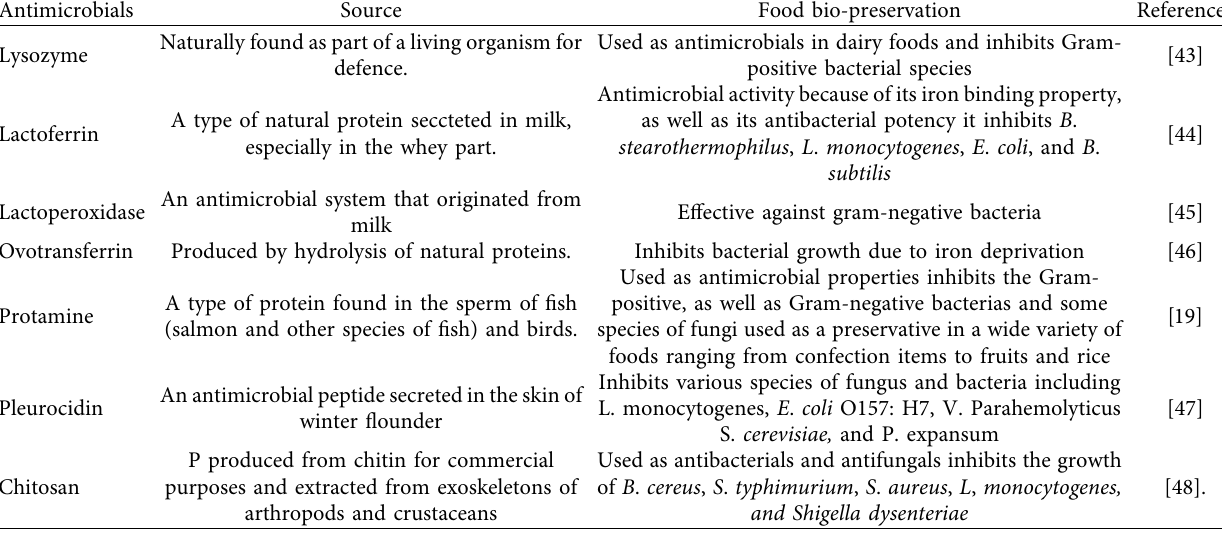
Table 2: Antimicrobial substances derived from animal sources and